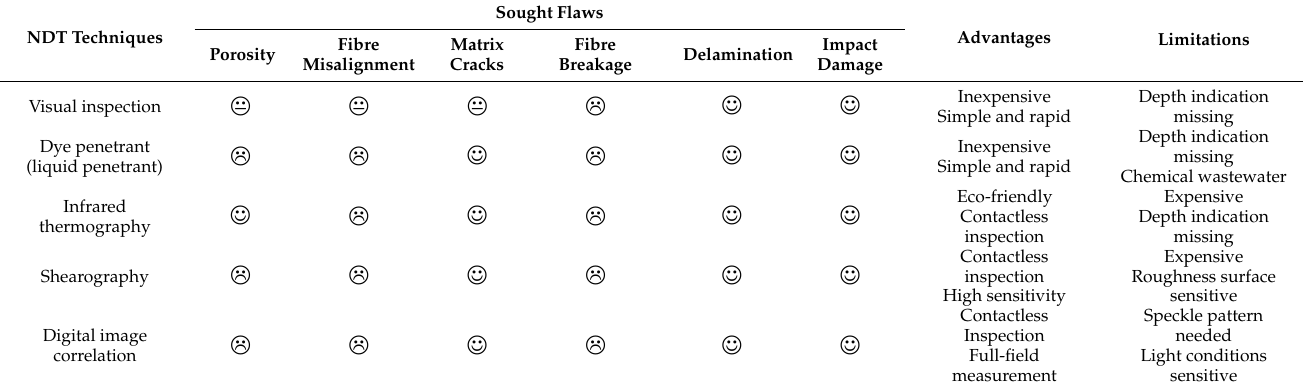
Table 1. Comparison of different surface non-destructive techniques.